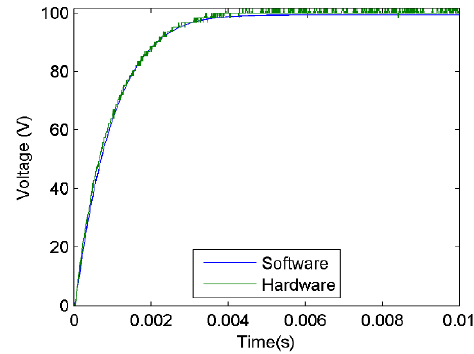
Figure 22. Voltage at the BCE output in open loop in the PVSE.